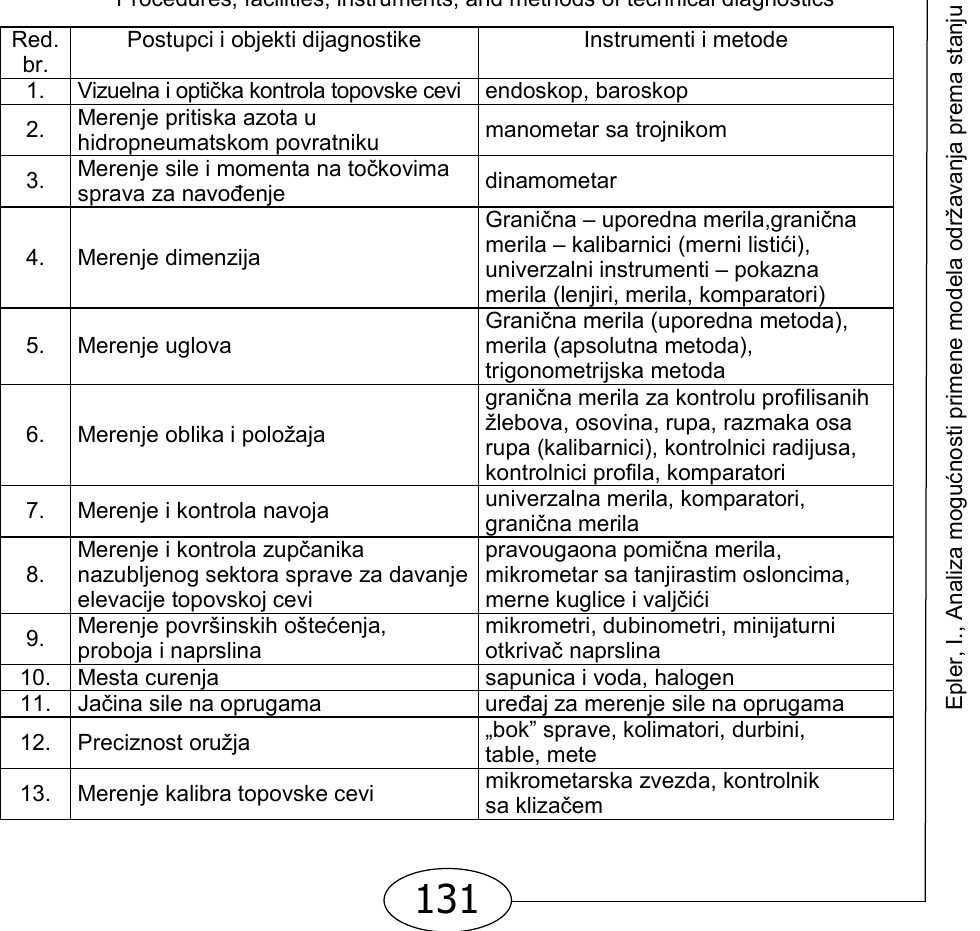
Postupci, objekti, instrumenti i metode tehni č ke